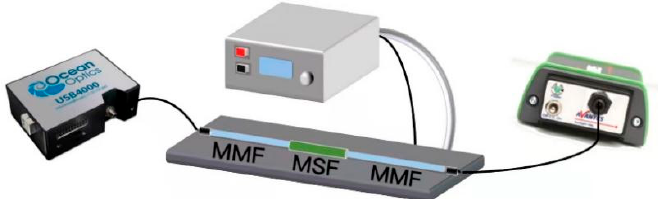
Figure 5. Experimental setup for testing the temperature sensor, including MMF and MSF coated with silver film and PDMS.